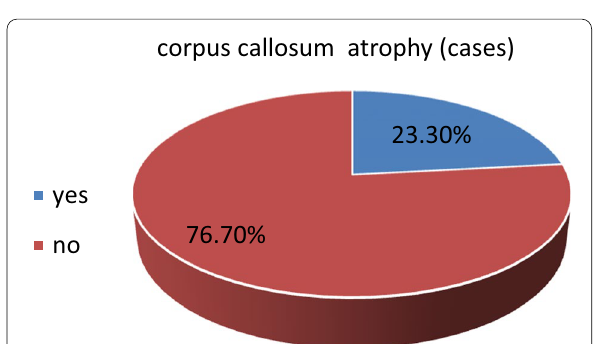
Fig. 7 Diagrammatic representation of percent of patients with corpus callosum atrophy